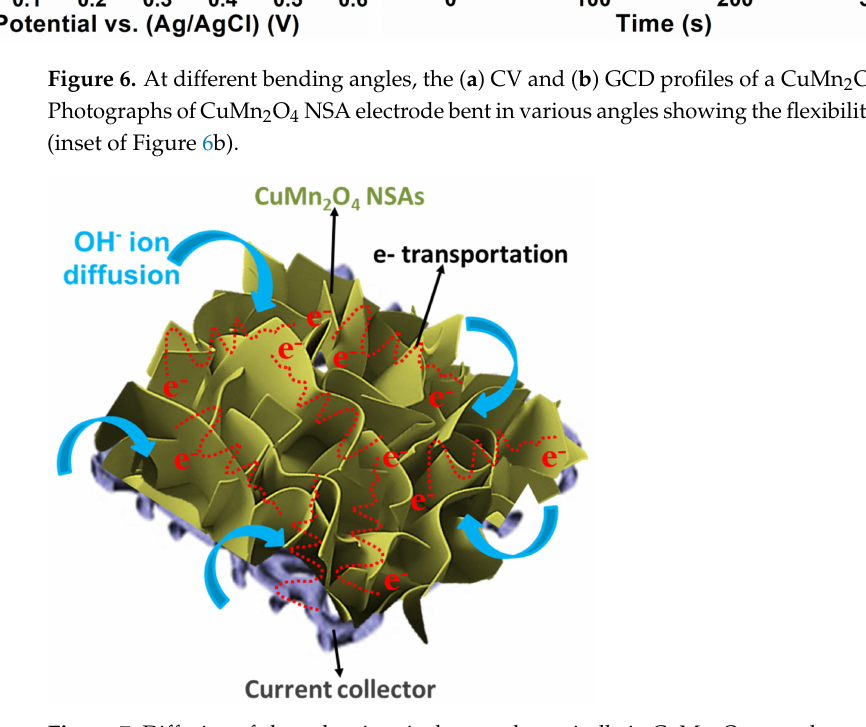
Figure 7. Diffusion of electrolyte ions is shown schematically in CuMn 2 O 4 nanosheet array